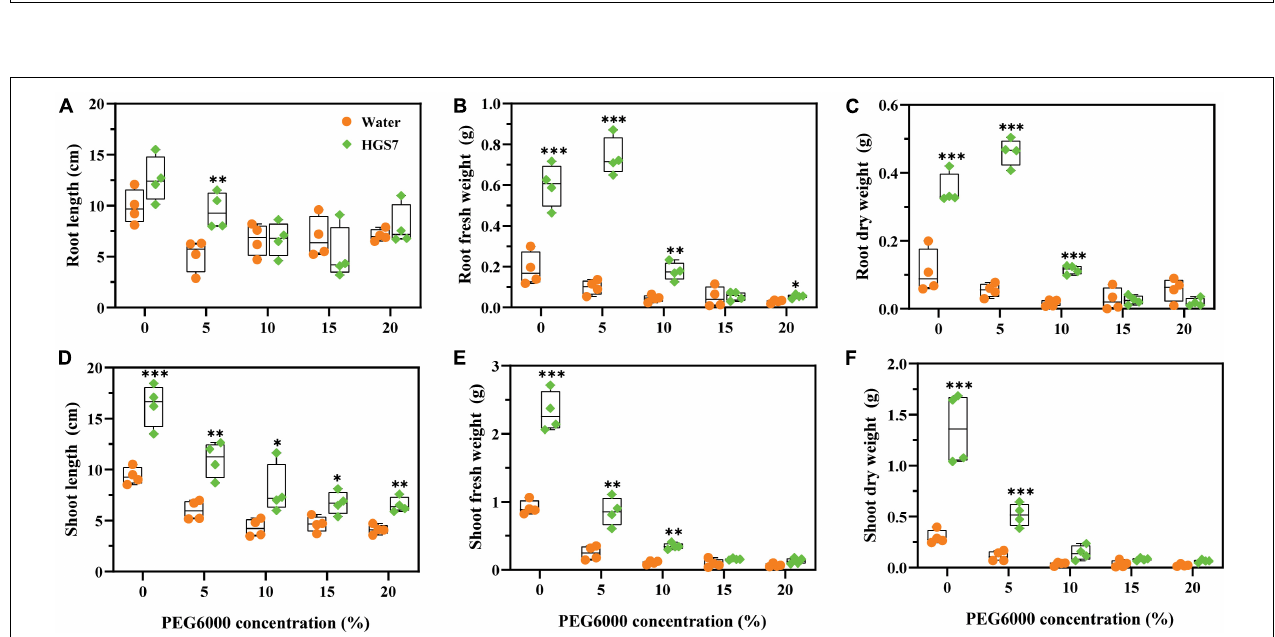
FIGURE 7 | Effects of B. megaterium HGS7 on mulberry recovery after suffering from drought stress. (A) Root length. (B) Root fresh weight. (C) Root dry weight. (D) Shoot length. (E) Shoot fresh weight. (F) Shoot dry weight. Data represent mean ± standard deviation ( n = 4), *** P < 0.001, ** P < 0.01, * P < 0.05.